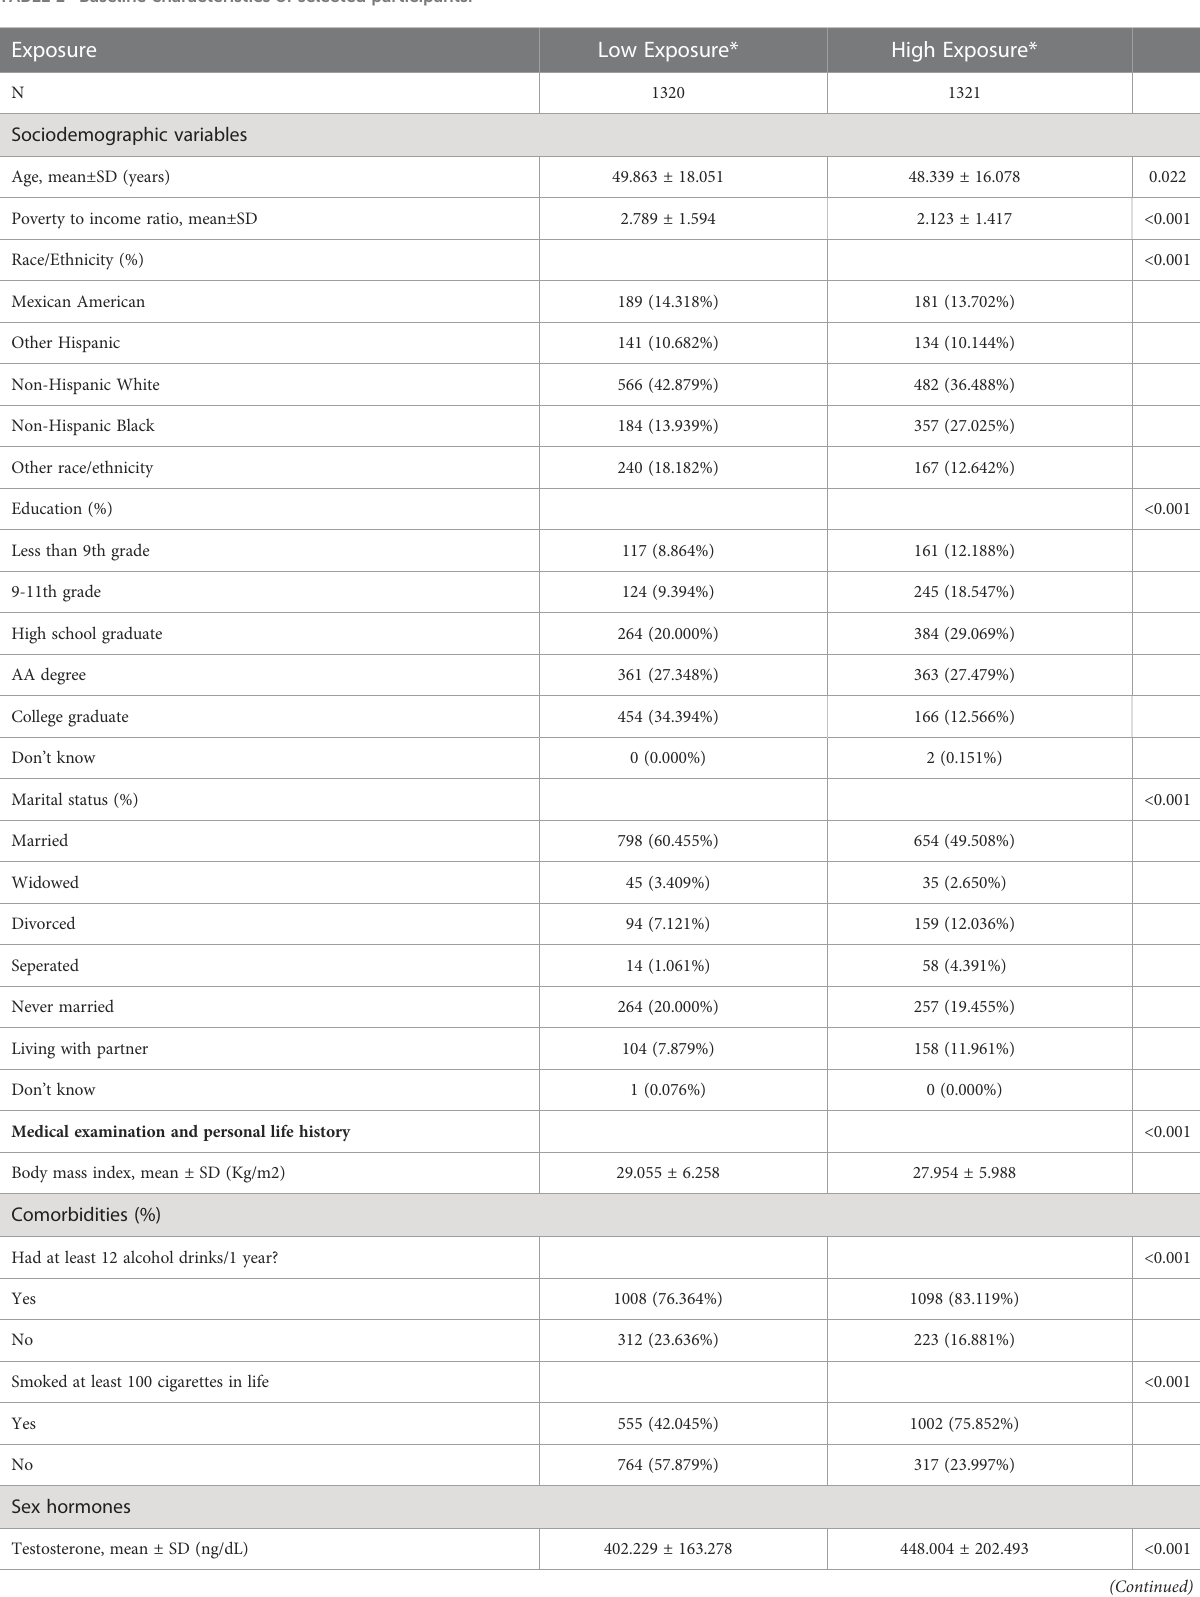
TABLE 1 Baseline characteristics of selected